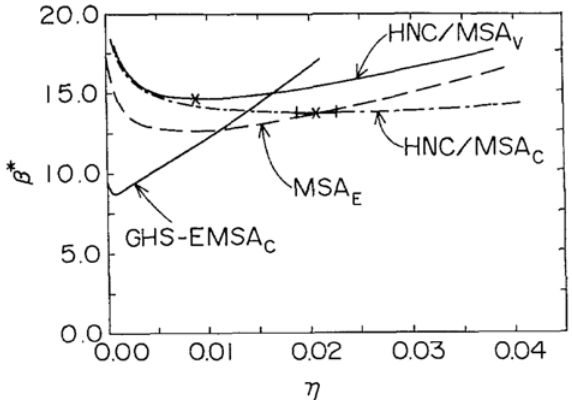
(b) Phase diagram of a z:z electrolyte like NaCl where n is the cation concentration. Lines show the position of the spinodal using methods appropriate for each theory, and the minimum indicates a critical point for fluctuation in ionic concentration. Note the temperature axis is reversed by β = z 2 /dk B T and η = π nd 3 / 6, d is the ion diameter. Reprinted from Ref. 35, with the permission of Figure 2. Comparing phase diagrams of the electron gas dissolved ions. Both show an insulating phase at low density (labeled Wigner crys- tal in (a)) and a conducting phase at high density separated by a minimum. The corresponding transition in an electron gas has not been well studied, but critical temperatures feature in the phase diagram of superconducting cuprates (where n is percent of solid impurities). 36